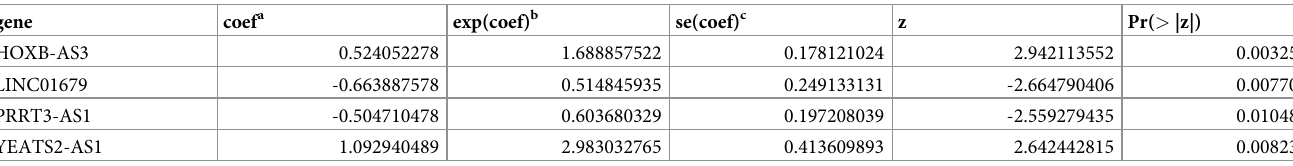
Table 3. Overview for the four prognostic lncRNAs related to PCa patient